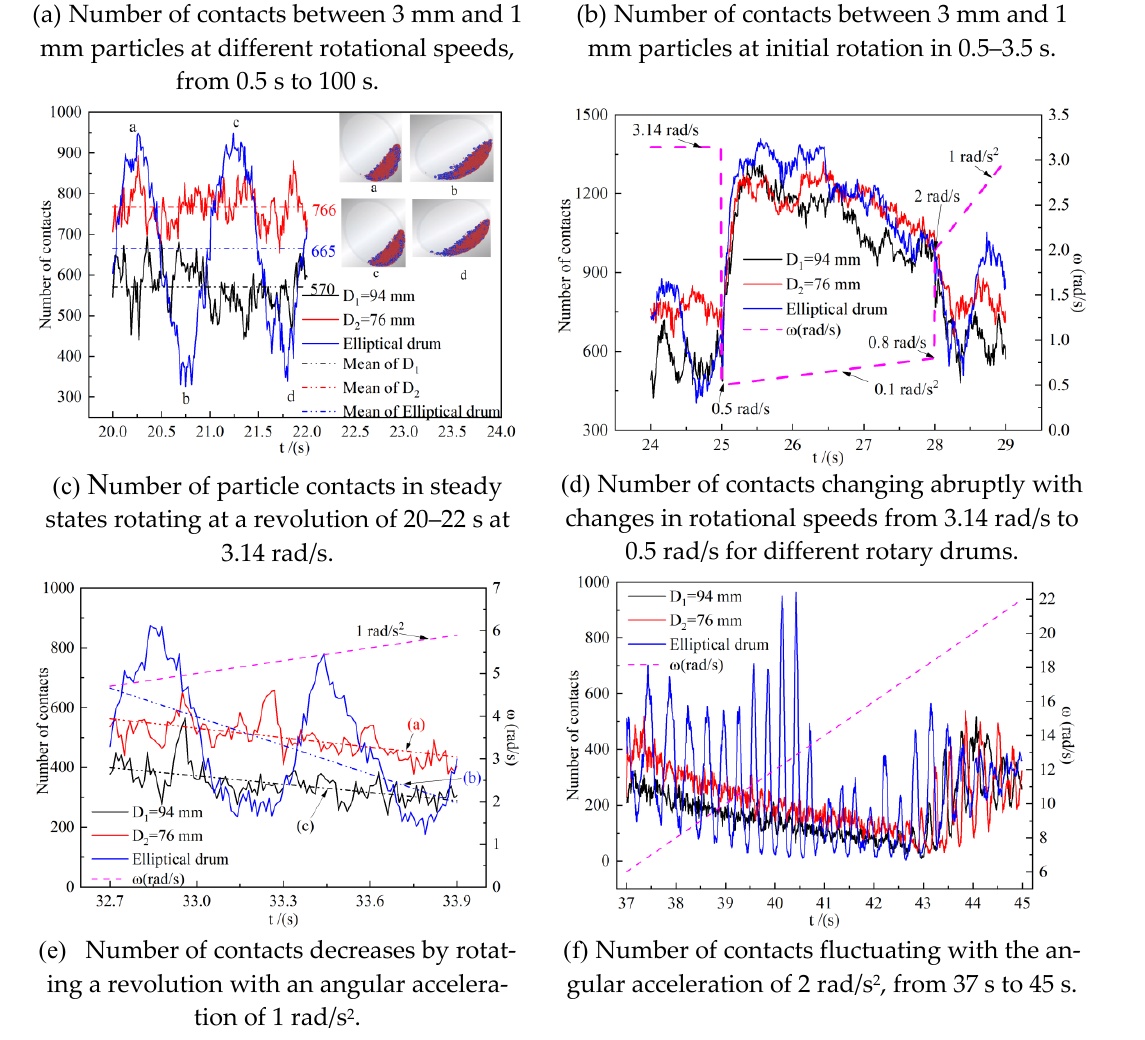
Figure 9. Evolution of the number of contacts for three different rotating drums at varying rotational speeds.